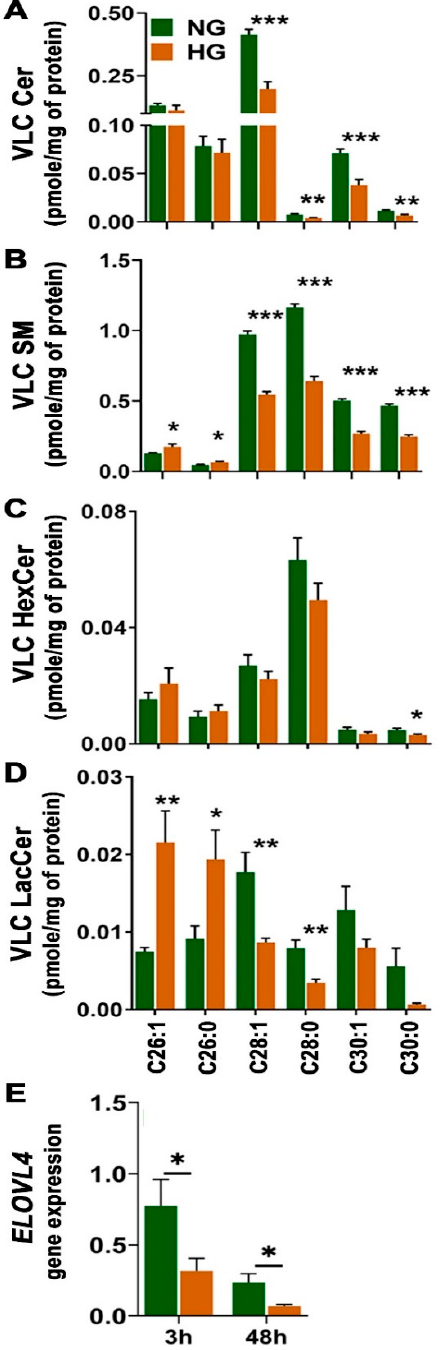
Figure 7. Differences in major VLC SPL levels and ELOVL4 gene expression in HREC cultured in 5 mM glucose (NG) or 25 mM glucose (HG) conditions. Levels of ( A ) VLC Cer, ( B ) VLC SM, ( C ) VLC HexCer, ( D ) VLC LacCer in HREC cultured in NG or HG for 48 h (pmol/mg protein; * p < 0.05, ** p < 0.01, *** p < 0.001; n = 6). ( E ) RT-qPCR gene expression analysis of ELOVL4 in HREC cultured in NG or HG media for 3 and 48 h (mean ± SEM; * p < 0.05; n = 3).